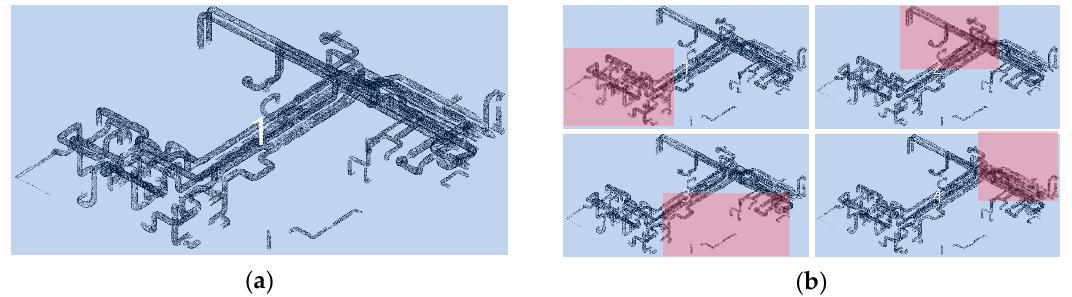
Figure 8. Single vs. multi core memory usage: ( a ) single core with one KDTree; ( b ) multi core with four KDTrees (The red box is a part used in the entire domain).